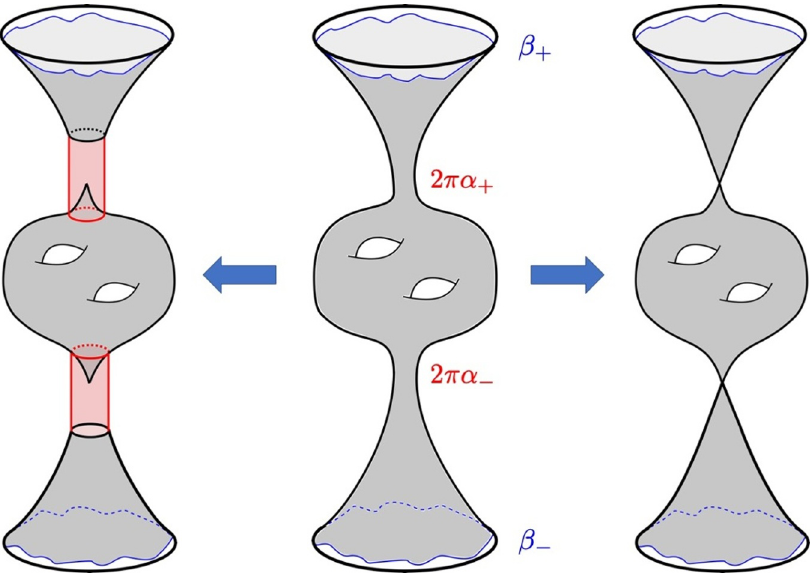
Figure 8 . Our higher genus geometries. We begin with some smooth surface equipped with a (cid:13)at PSL(2; R ) connection, pictured in the middle. It has asymptotic boundaries, around which there are elliptic holonomies characterized by (cid:11) i . From this connection we may obtain a mixed-signature metric, pictured on the left. It has Lorentzian dS 2 regions glued to an intermediate R = (cid:0) 2 surface (cid:6) with cone points. The Lorentzian regions have minimal geodesics of lengths 2 (cid:25)(cid:11) i , matching the cone angles of (cid:6). Equivalently, we can extract a Euclidean R = (cid:0) 2 geometry pictured on the right, in which the asymptotic regions are replaced with hyperbolic cones of opening angles 2 (cid:25)(cid:11) i glued to the circles at I (cid:6)